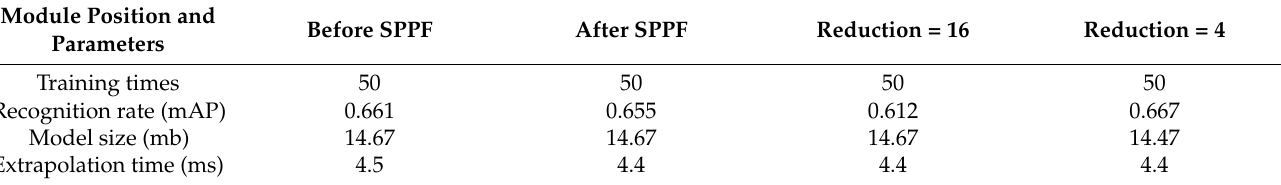
Table 4. SE module experimental parameter